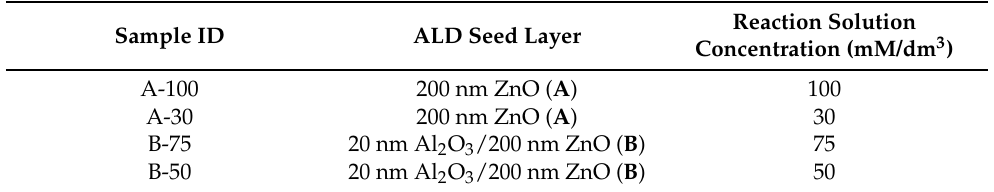
Table 2. Growth parameters used in ALD and CBD processes of samples’ fabrication.